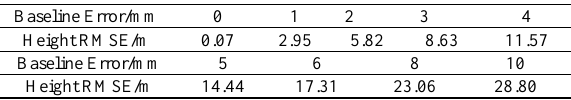
Table 2. Statistical results of the height error induced by baseline error